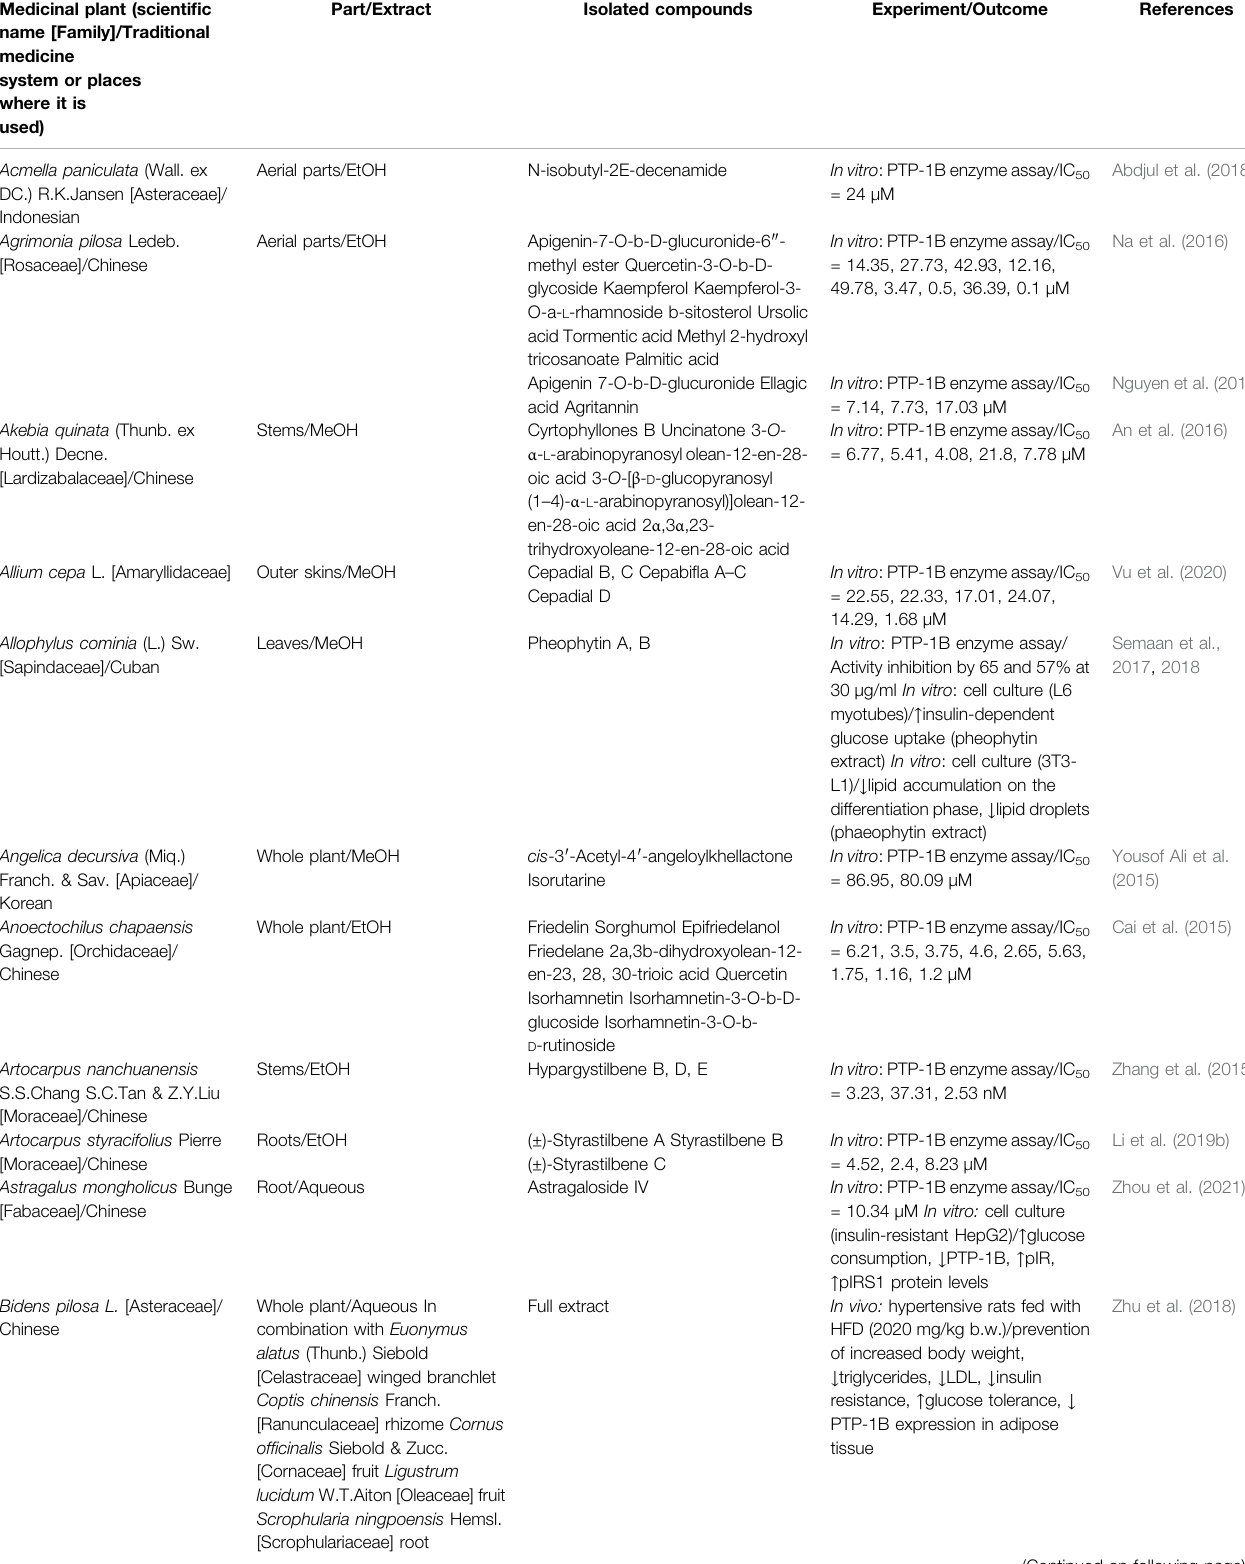
TABLE 1 | Medicinal plants and their phytochemicals with PTP-1B inhibitory capacity. Medicinal plant (scienti fi c name [Family]/Traditional medicine system or